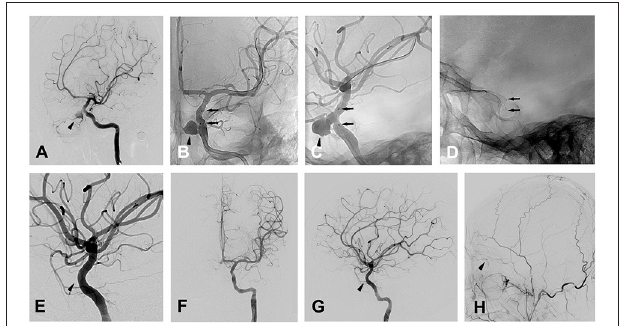
FIGURE 3 | Patient 13 (A) oblique views of a left ICA angiogram showing the traumatic OphA aneurysm. (B,C) radioscopic anteroposterior (B) and oblique (C) views of the implanted stent during the left ICA angiogram. Black arrow heads indicate the pseudoaneurysm close to the ophthalamic artery in (A–C) , black arrows indicate the stent in (B–G) , oblique (E) , anteroposterior (F) and lateral (G) views of a left ICA angiogram showing the complete occlusion of the pseudoaneurysm, with black arrow head indicating the absence of the pseudoaneurysm as well as ophthalamic artery. (H) Lateral (G) view of a left ECA angiogram showing the presence of the collateral flow from ECA to OphA (black arrow